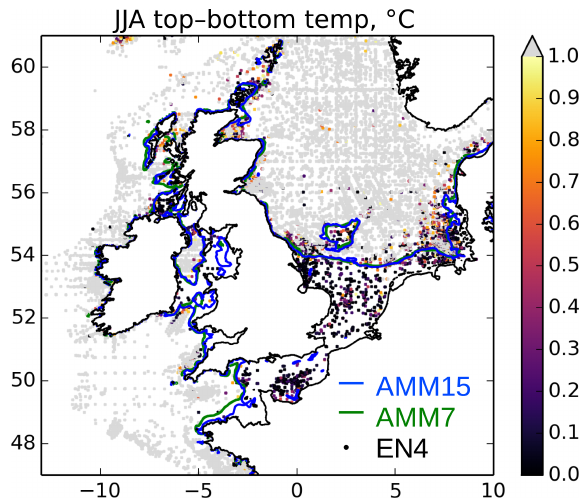
Figure 5. Mean summer stratification indicated by top–bottom tem- perature difference ( ◦ C). Blue and green lines contour regions with a mean top–bottom temperature difference of 0.5 ◦ C in AMM15 and AMM7, respectively. Model results show the seasonal mean (JJA) for 1991–2010, indicating the location of seasonal tidal mix- ing fronts. Shading shows the observed temperature difference (top– bottom) from all monthly mean EN4 profiles during 1991–2010 (Good et al., 2013). Points showing > 1 ◦ C are coloured grey for